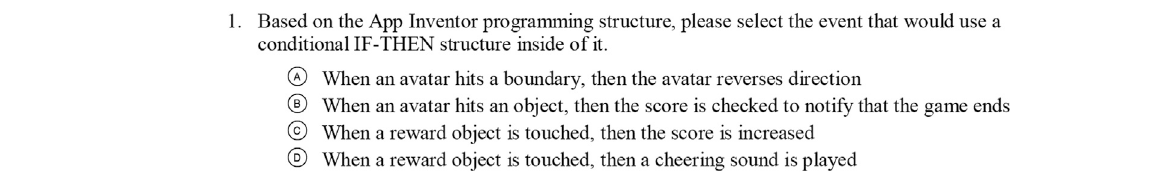
FIGURE 4 | Sample item: Unit 4 assessment, item